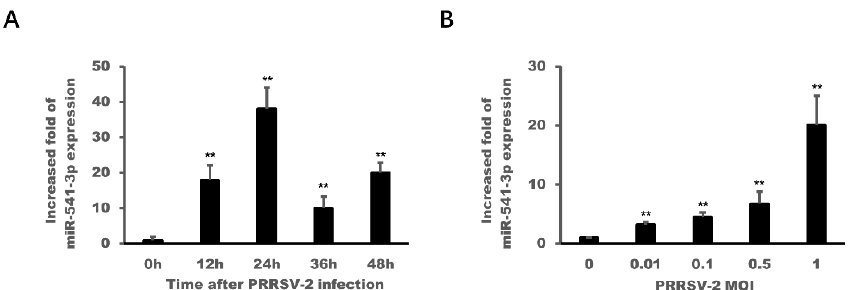
Figure 2. PRRSV-2 infection up-regulated the expression of miR-541-3p in MARC-145 cells. ( A ) MARC-145 cells were infected with PRRSV-2 (multiplicity of infection (MOI) = 1) for indicated times. Then, the expression levels of miR-541-3p were determined by quantitative real time polymerase chain reaction (qRT-PCR). ( B ) MARC-145 cells were infected with PRRSV-2 at different MOIs, and 24 h later, the expression levels of miR-541-3p were measured by qRT-PCR. All experiments were repeated at least three times with similar results. ** p < 0.01.